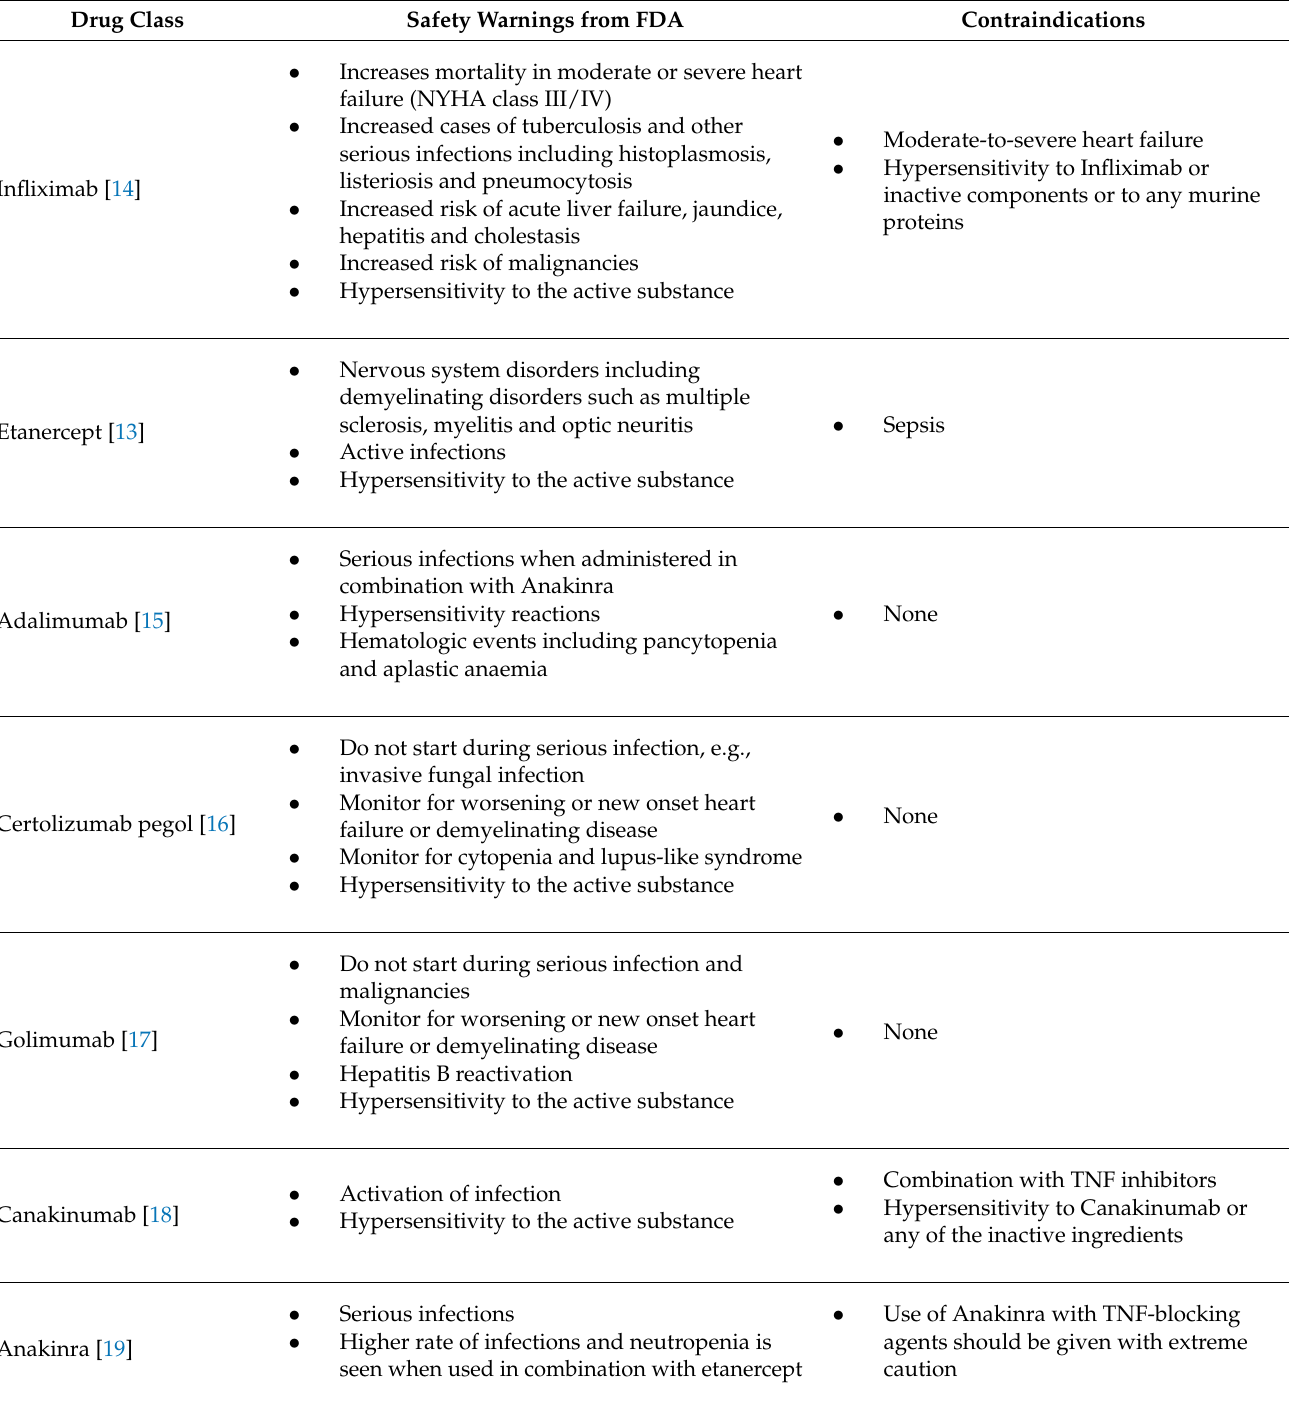
Table 7. Safety considerations for the use of bDMARDs reported by the Food and Drug